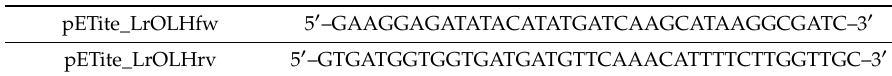
Table 2. Primer used for cloning OLH from L. rhamnosus ATCC 53103.